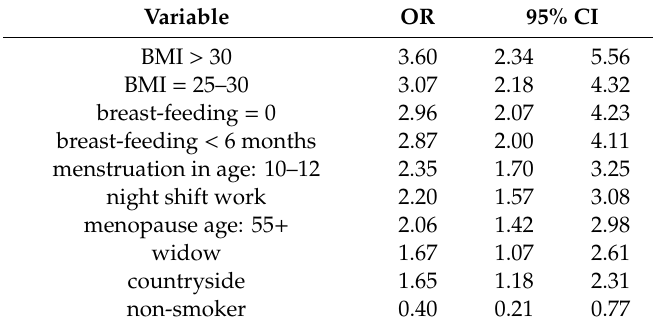
Table 3. Statistically significant odds ratios (ORs) (ordered in descending